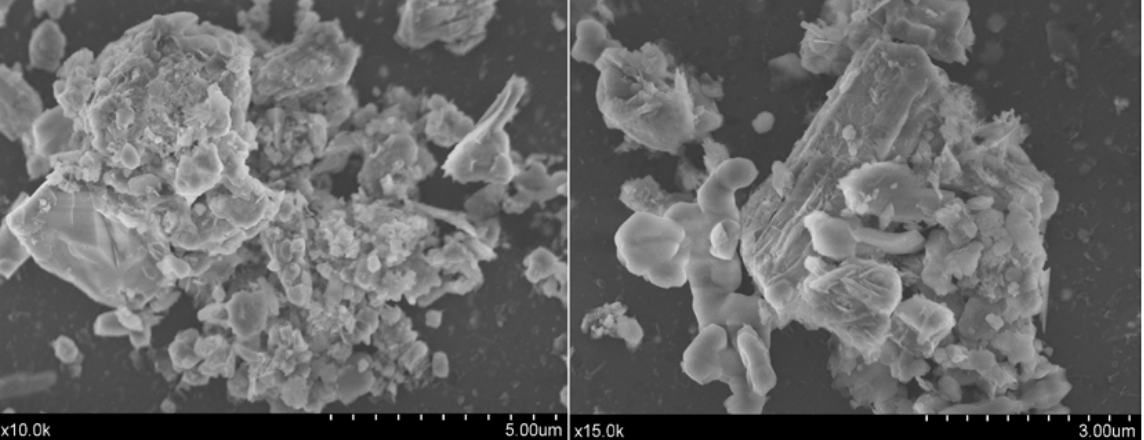
Figure 3. N2 adsorption desorption curve and pore diameter distribution of steel slag.